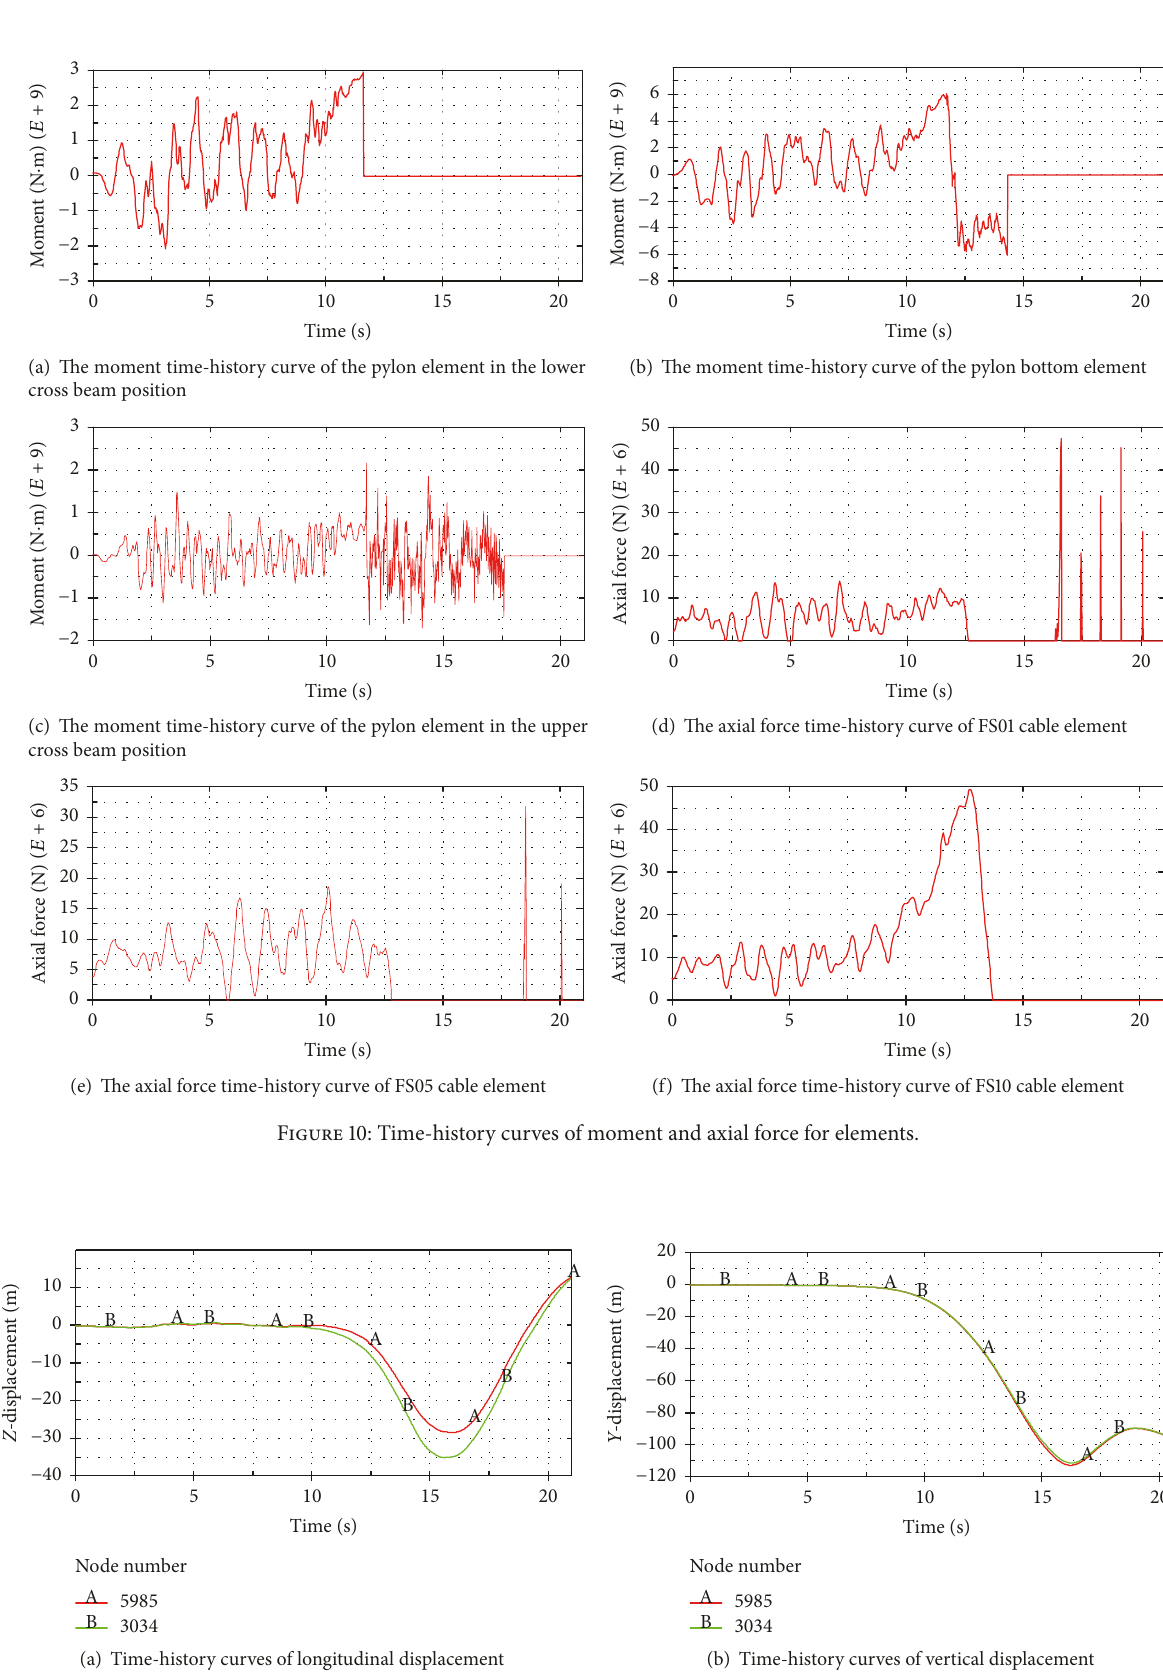
Figure 11: The displacement time-history curves of A and B nodes of girder